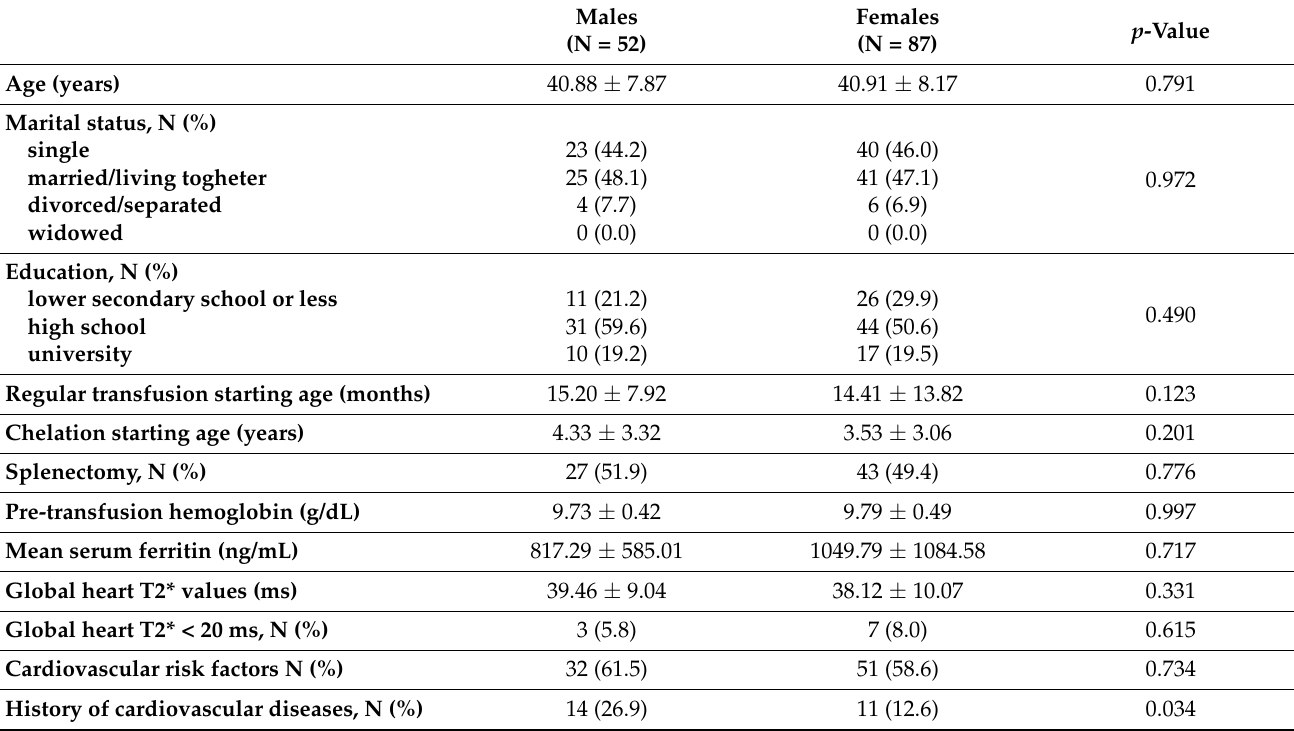
Table 1. Comparison of demographics and health characteristics between male and female respon-